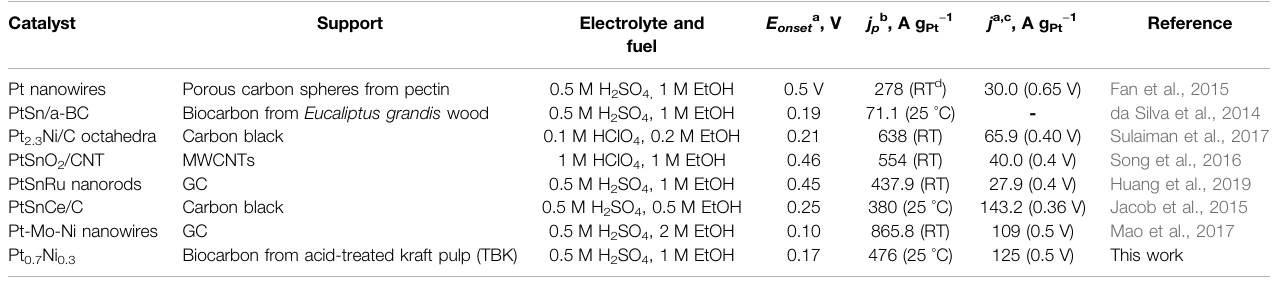
TABLE 5 | Performance of different electrocatalysts for the EOR process in acid